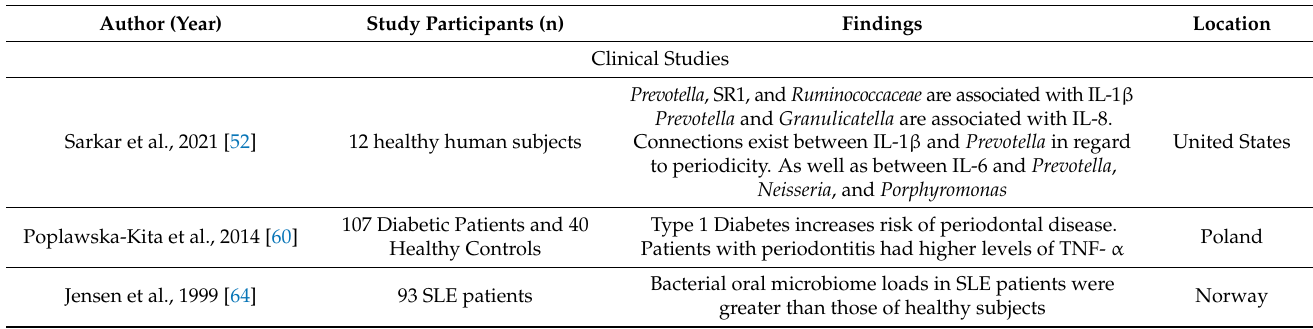
Table 1. The Oral Microbiome and Inflammation